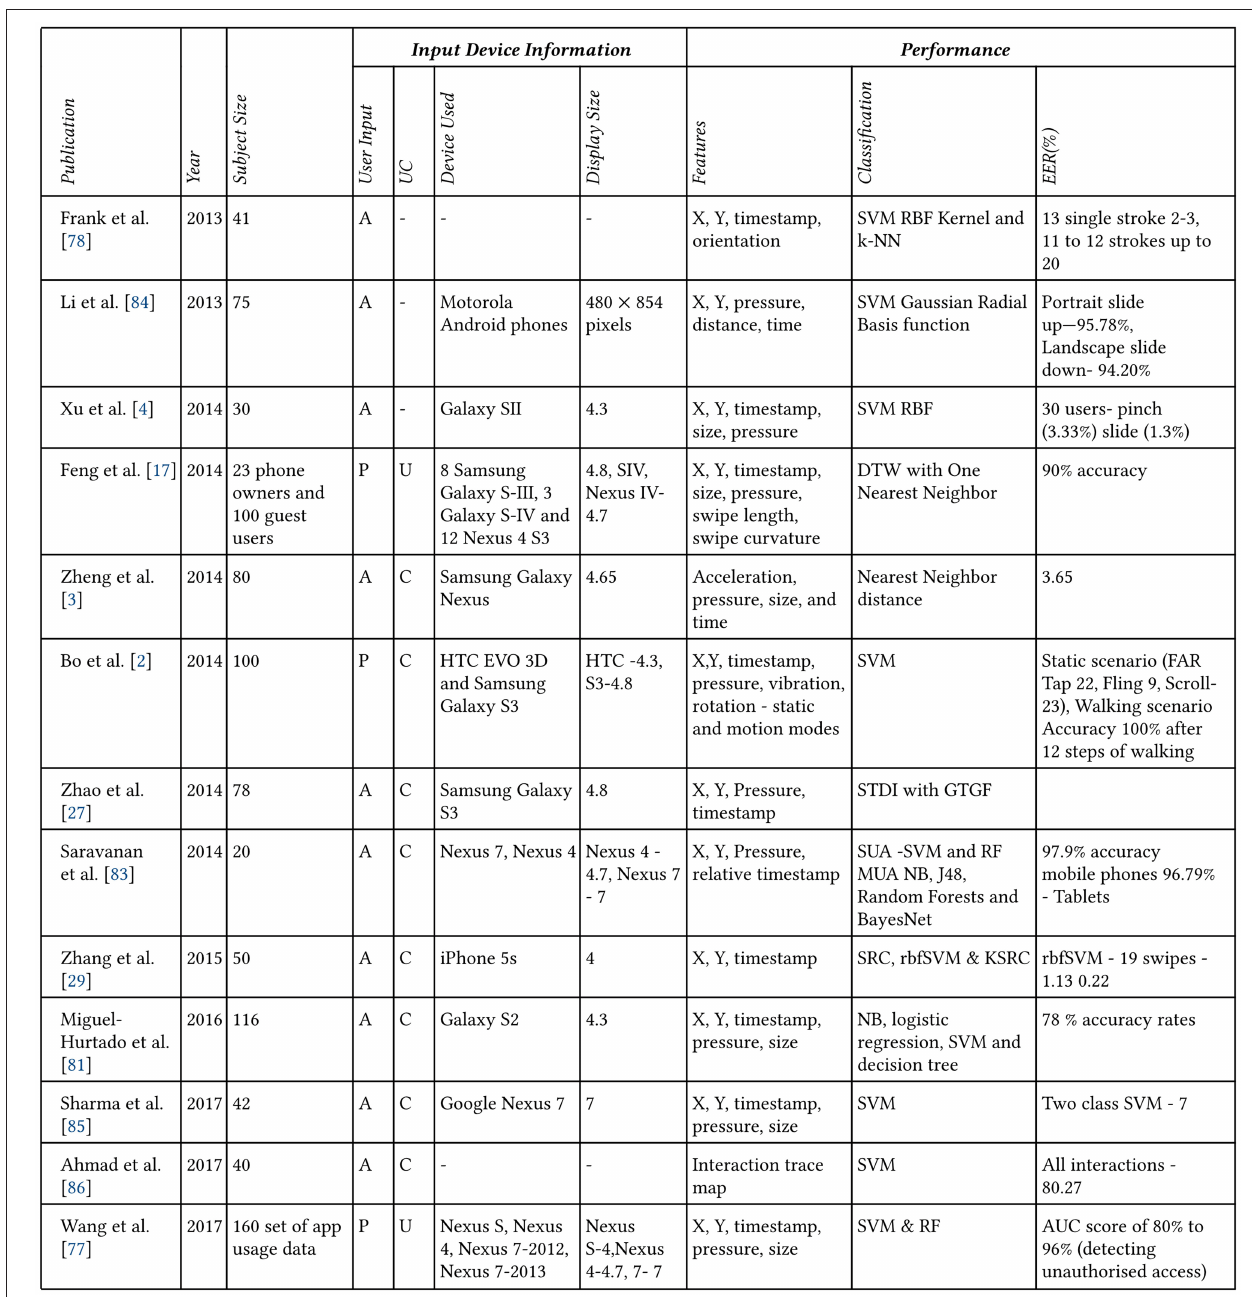
FIGURE 3 | The progression of touch dynamics research, which has evolved into what is presently called touchalytics. Taken from Ellavarason et al. (2020).